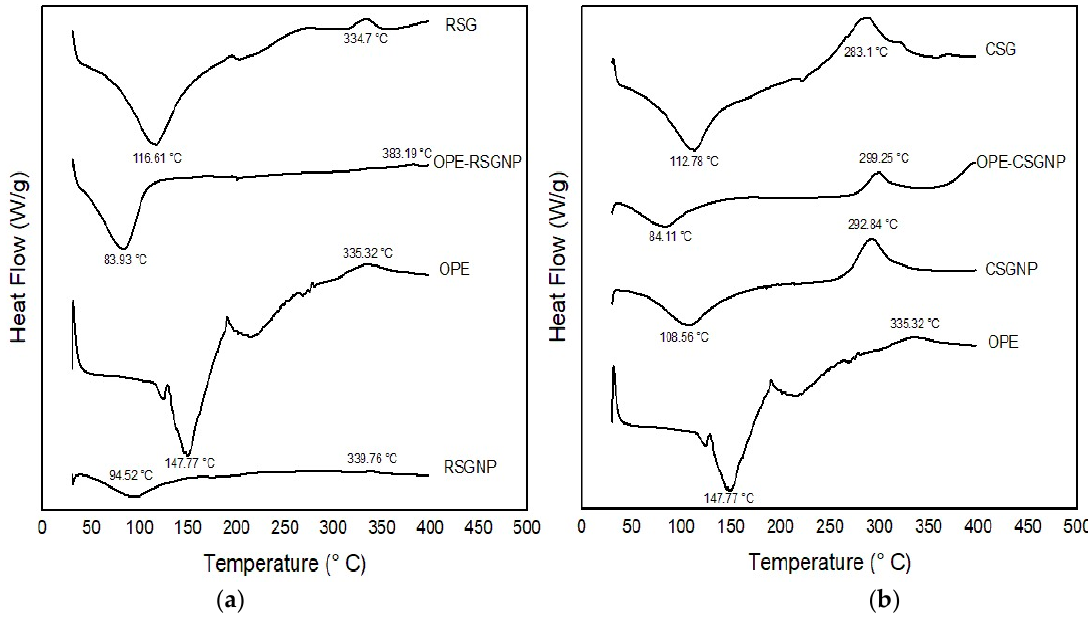
Figure 2. Comparison of the DSC thermograms of the ( a ) OPE, RSG, RSGNP, OPE-RSGNP, ( b ) OPE, CSG, CSGNP and